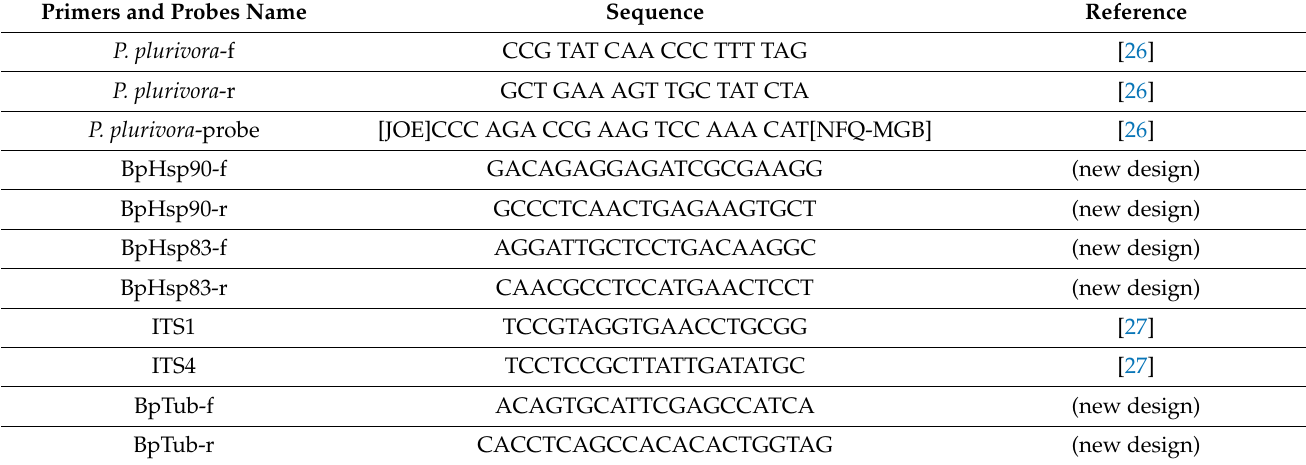
Table 1. List of